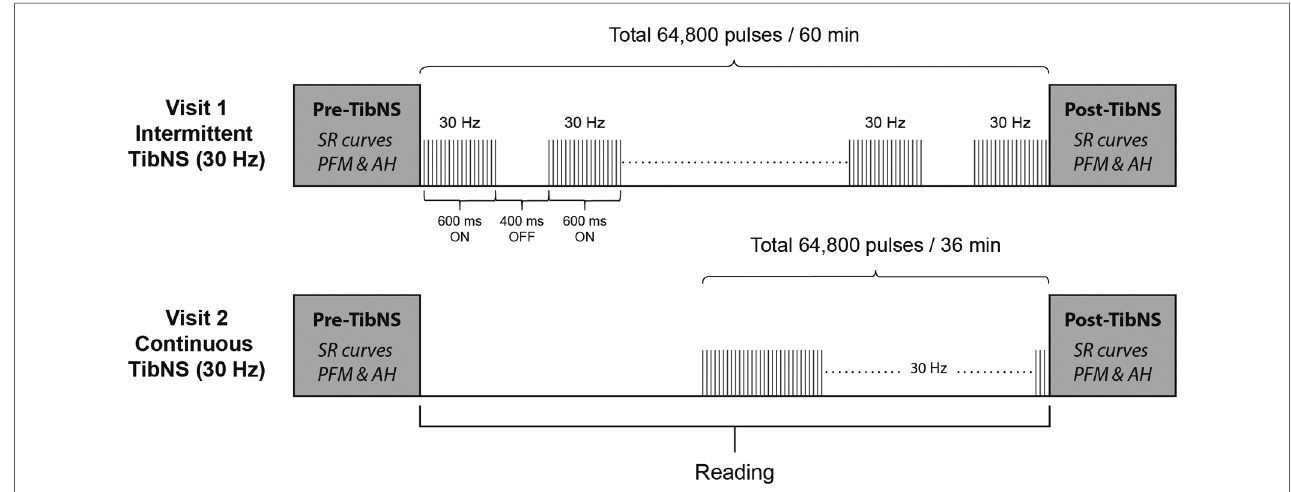
FIGURE 1 Schematic of the study protocol and TibNS interventions. Intermittent TibNS (30 Hz), continuous TibNS (30 Hz) with a total of 64,800 pulses were applied. The pulse amplitudes were equalized between these stimulation parameters, and pulse width duration set at 1